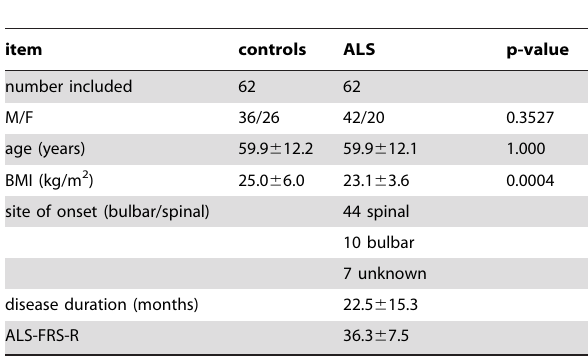
Table 1. Characteristics of patients and controls.